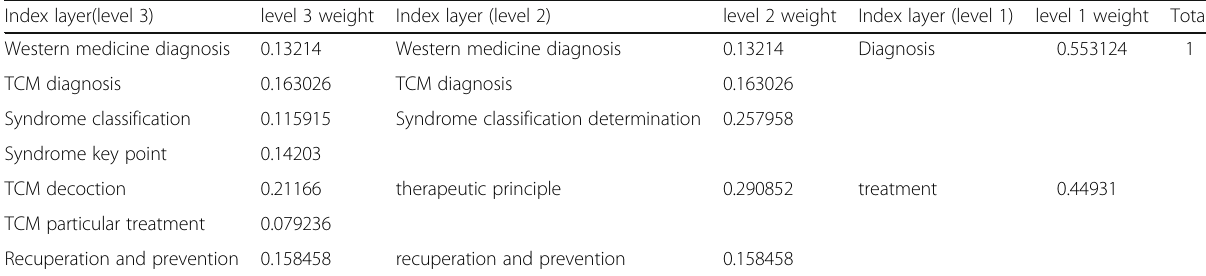
Table 3 The weight of each index